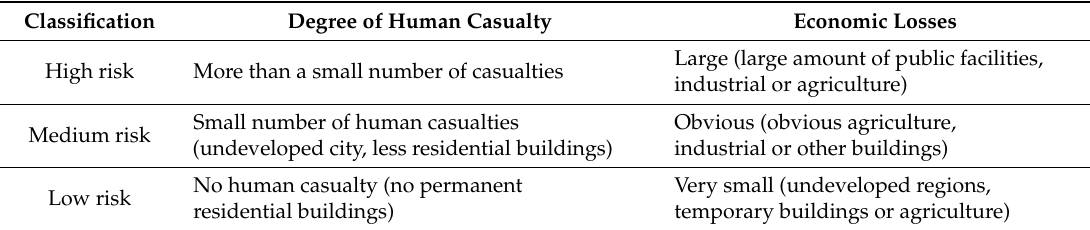
Table 6. Classification of dam risks by